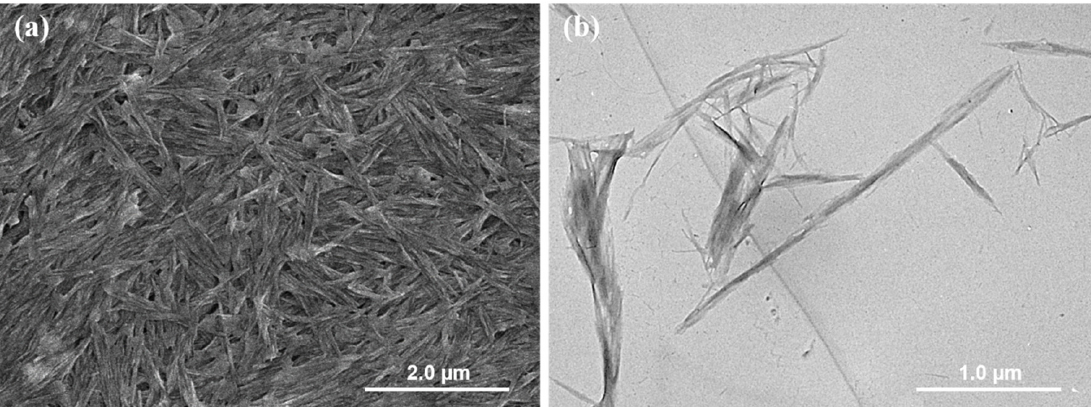
Figure 1. ( a ) SEM image and ( b ) TEM image of BCNs.